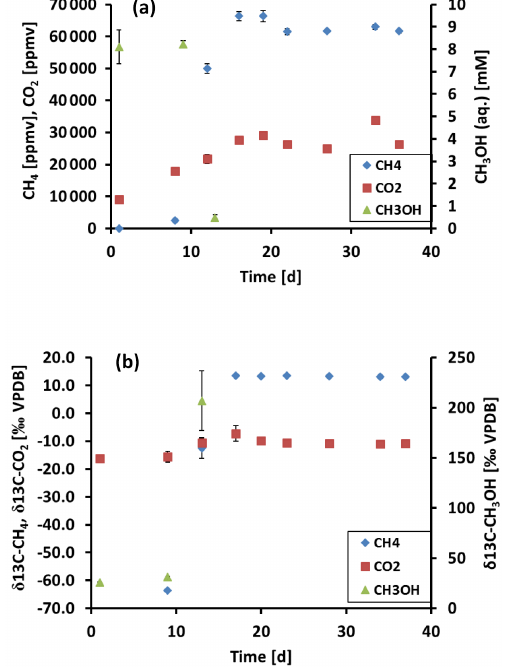
Figure 7. Development of headspace gas content and isotope com- position of methane (CH 4 ) and carbon dioxide (CO 2 ) as well as porewater methanol (CH 3 OH) concentration and isotope composi- tion during the 13 C-labeling experiment (with sediment from the 0–2cmb.s.f. horizon in September 2014) with the addition of 13 C- enriched methanol ( 13 C: 12 C = 1:1000). (a) Concentrations of pore- water methanol (CH 3 OH) and headspace content of methane (CH 4 ) and carbon dioxide (CO 2 ) over time. (b) Isotope composition of porewater CH 3 OH, headspace CH 4 , and headspace CO 2 over time. Shown are means (from triplicates) with standard deviation.